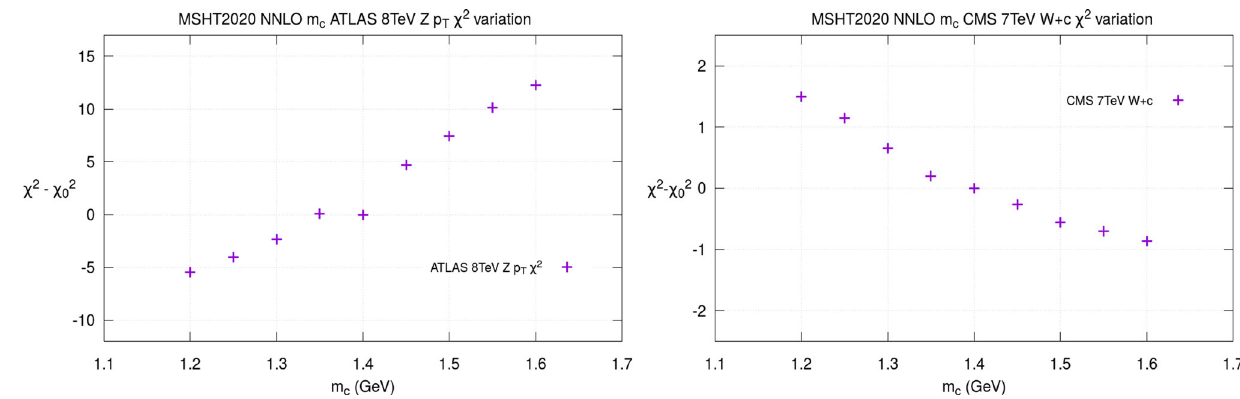
) = 0 . 118 for (left) the ATLAS 8 TeV Z p Z